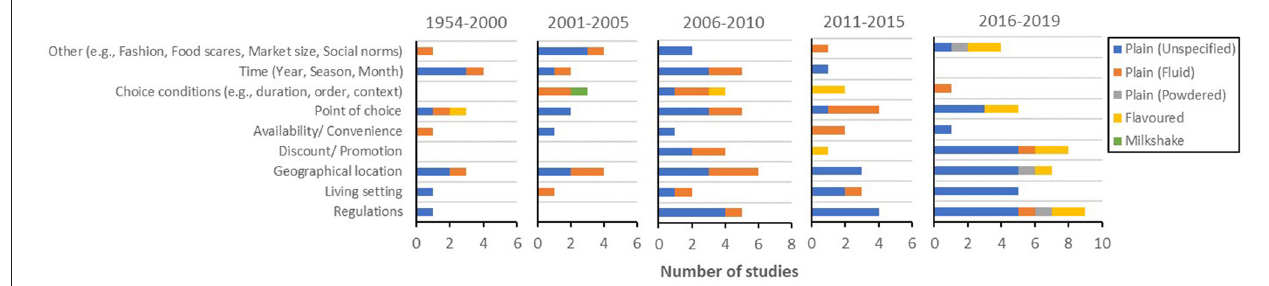
FIGURE 13 | Prevalence of context-related empirical studies for each milk type [i.e., plain (unspecified), plain (fluid), plain (powdered), flavoured milk, milkshake, and other milk drinks] during each period (i.e., 1954–2000, 2001–2005, 2006–2010, 2011–2015), and